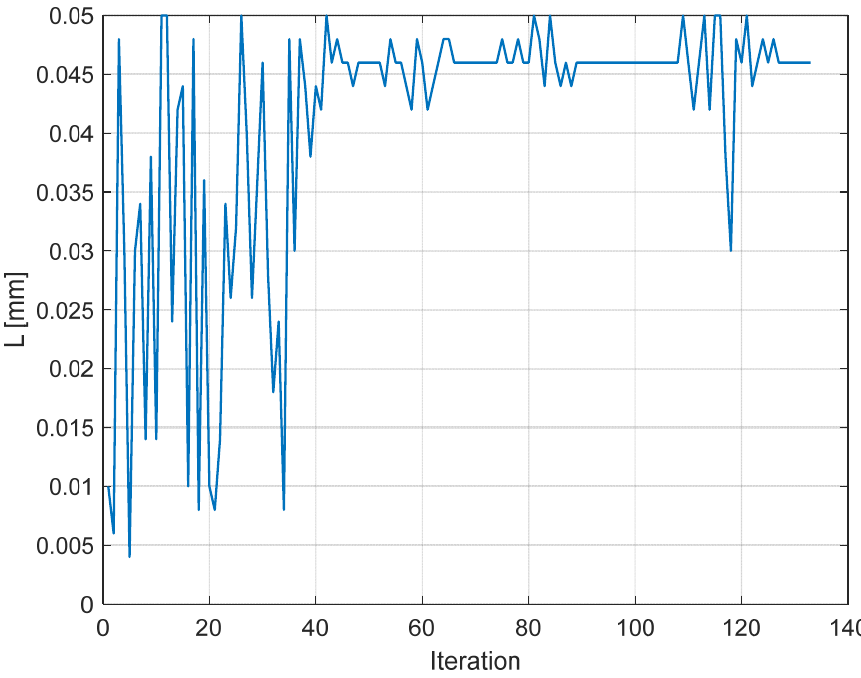
Figure 11. History of the optimization process. The changes in the L parameter over iterations.